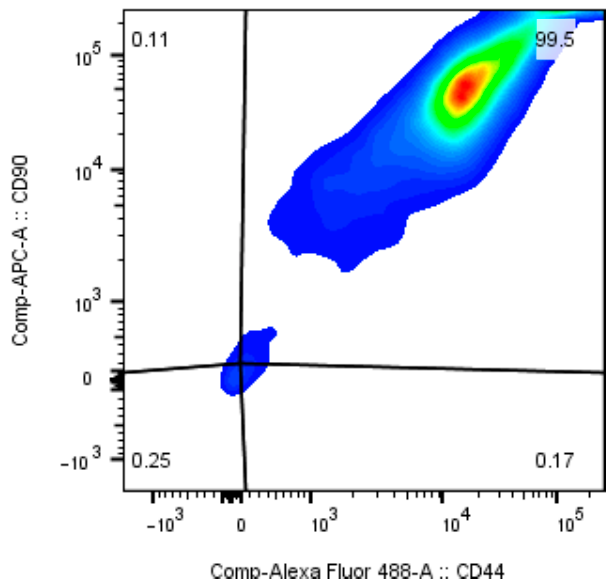
Figure 7. Cultured ASCs are positive for CD44 and CD90.